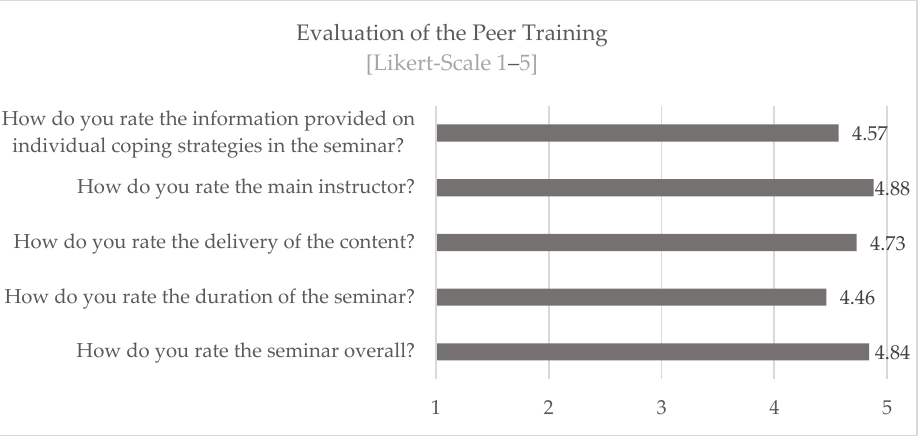
Figure 8. Evaluation of the Peer Training.